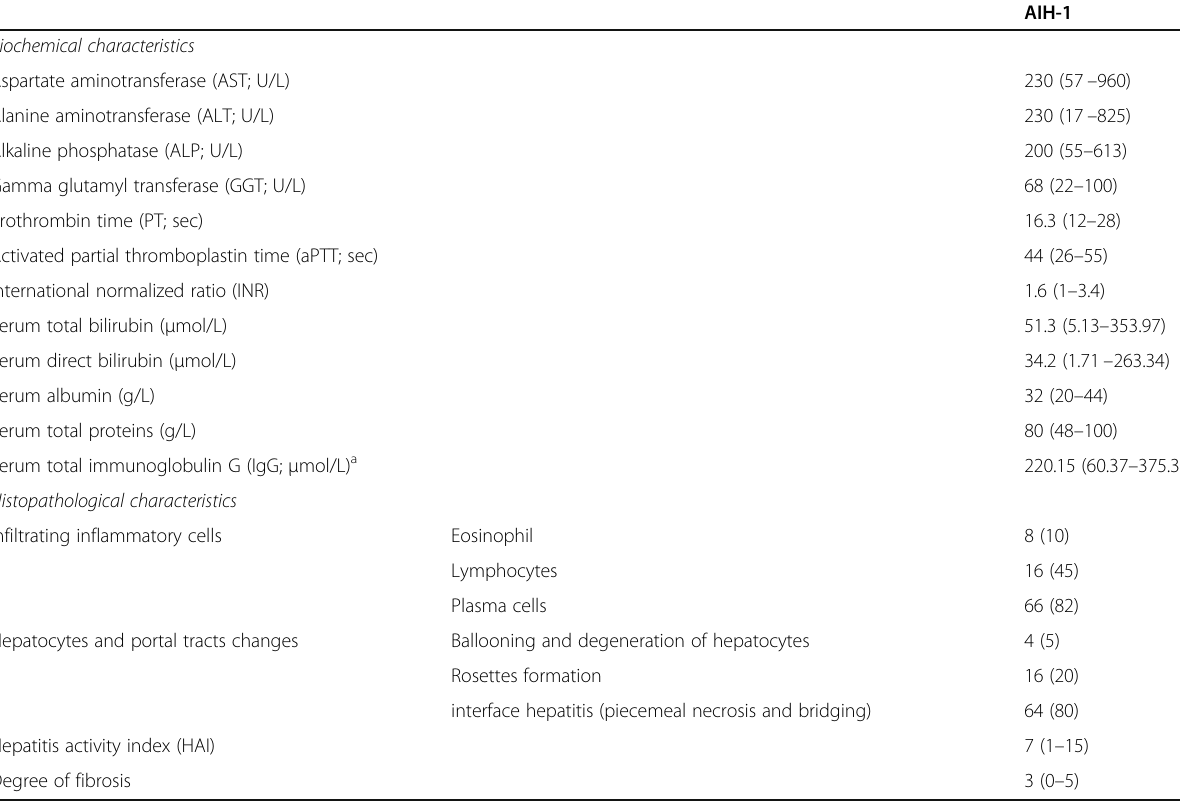
Table 1 Baseline characteristics of AIH-I patients ( n =